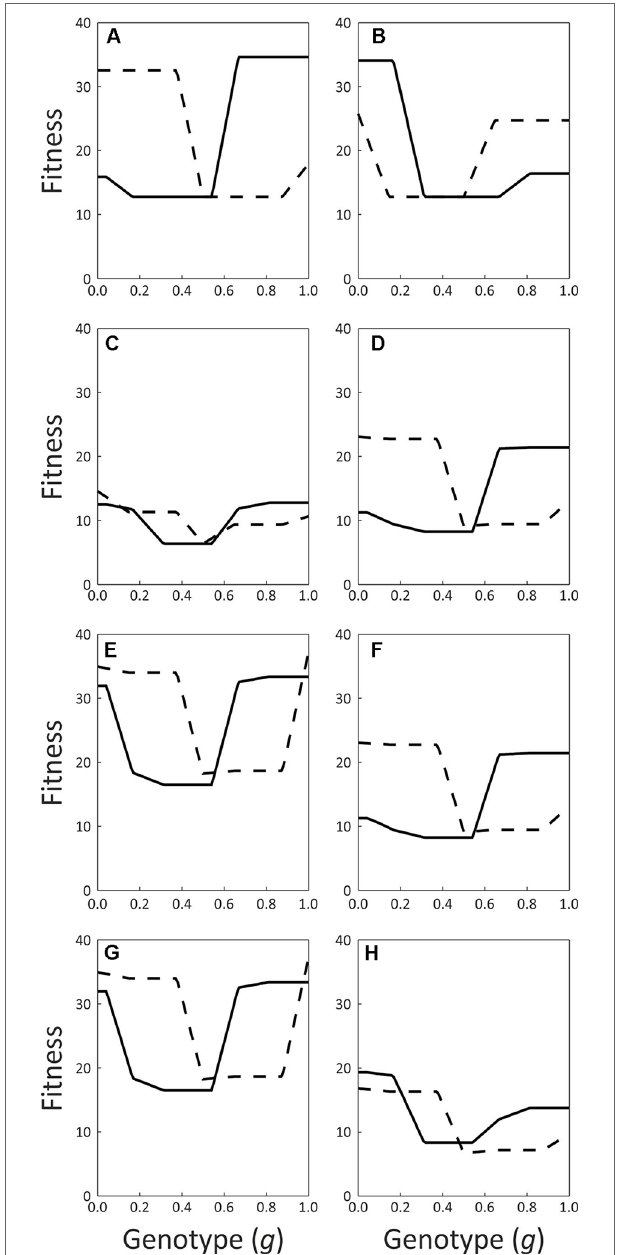
FIGURE 7 | Functions describing the fitness (in arbitrary units) for all possible genotypes of the Early (solid lines) and Late (dashed lines) flowering morphs. (A) pollinators visit only in the morning, (B) pollinators visit only in the afternoon, (C) pollinators visit throughout the day, d-g: visits by flies, rates are as observed in the field. Mating incompatibility occurs within flowering morphs and genotypes (D) , within flowering morphs only (E) , within genotypes only (F) or never (G) . h: visits by honeybees and flies, rates are as observed in the field. See Table 2 for additional